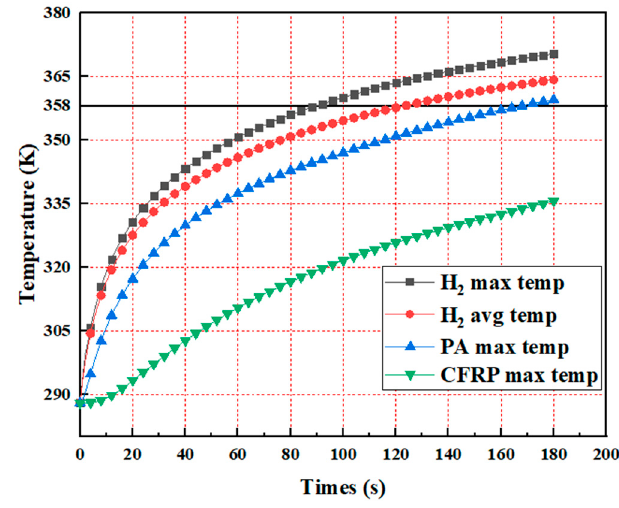
Figure 8. Temperature evolutions of the hydrogen and solid materials.